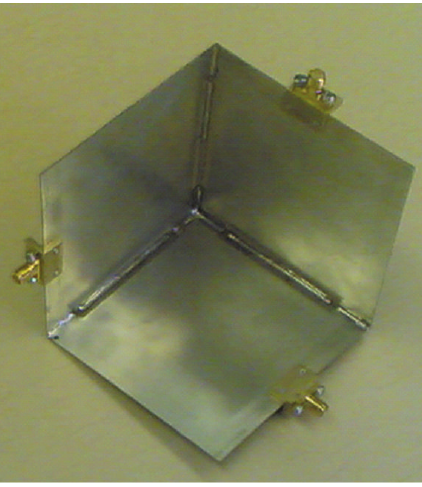
Figure 18: 3 antennas on the edges.